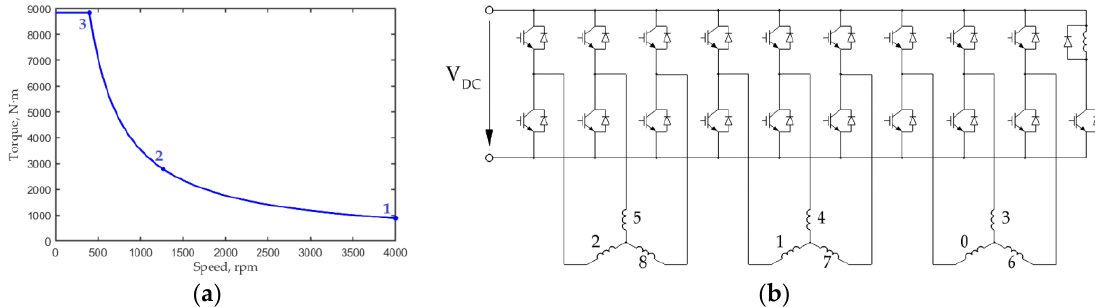
Figure 2. SHM diagrams: ( a ) traction characteristic of the motor; ( b ) inverter schematic; the numbers from 1 to 9 are the numbers of the phases of the SHM.